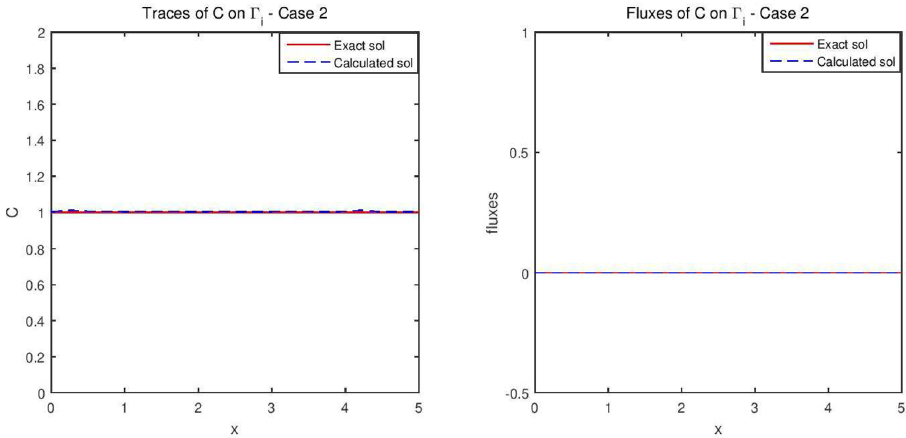
Figure 6. The reconstructed concentration—Case 2.